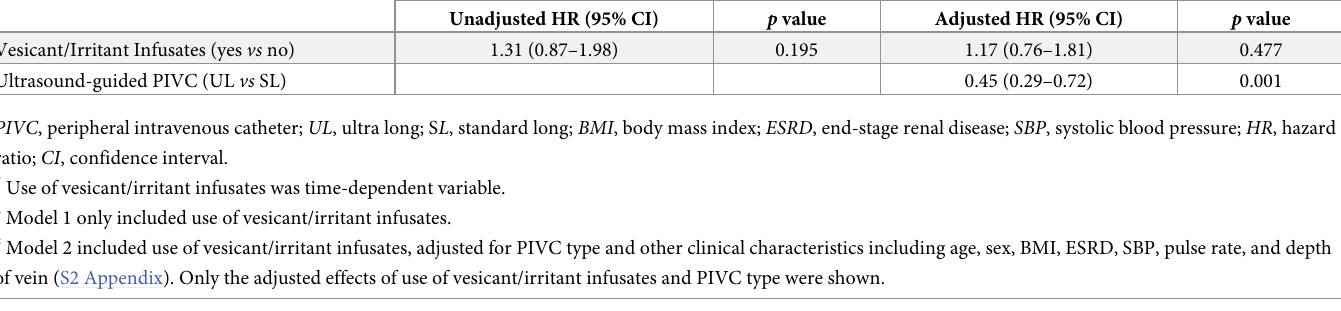
Table 3. Effects of any use of vesicant/irritant infusates on intravenous line failure. Effects